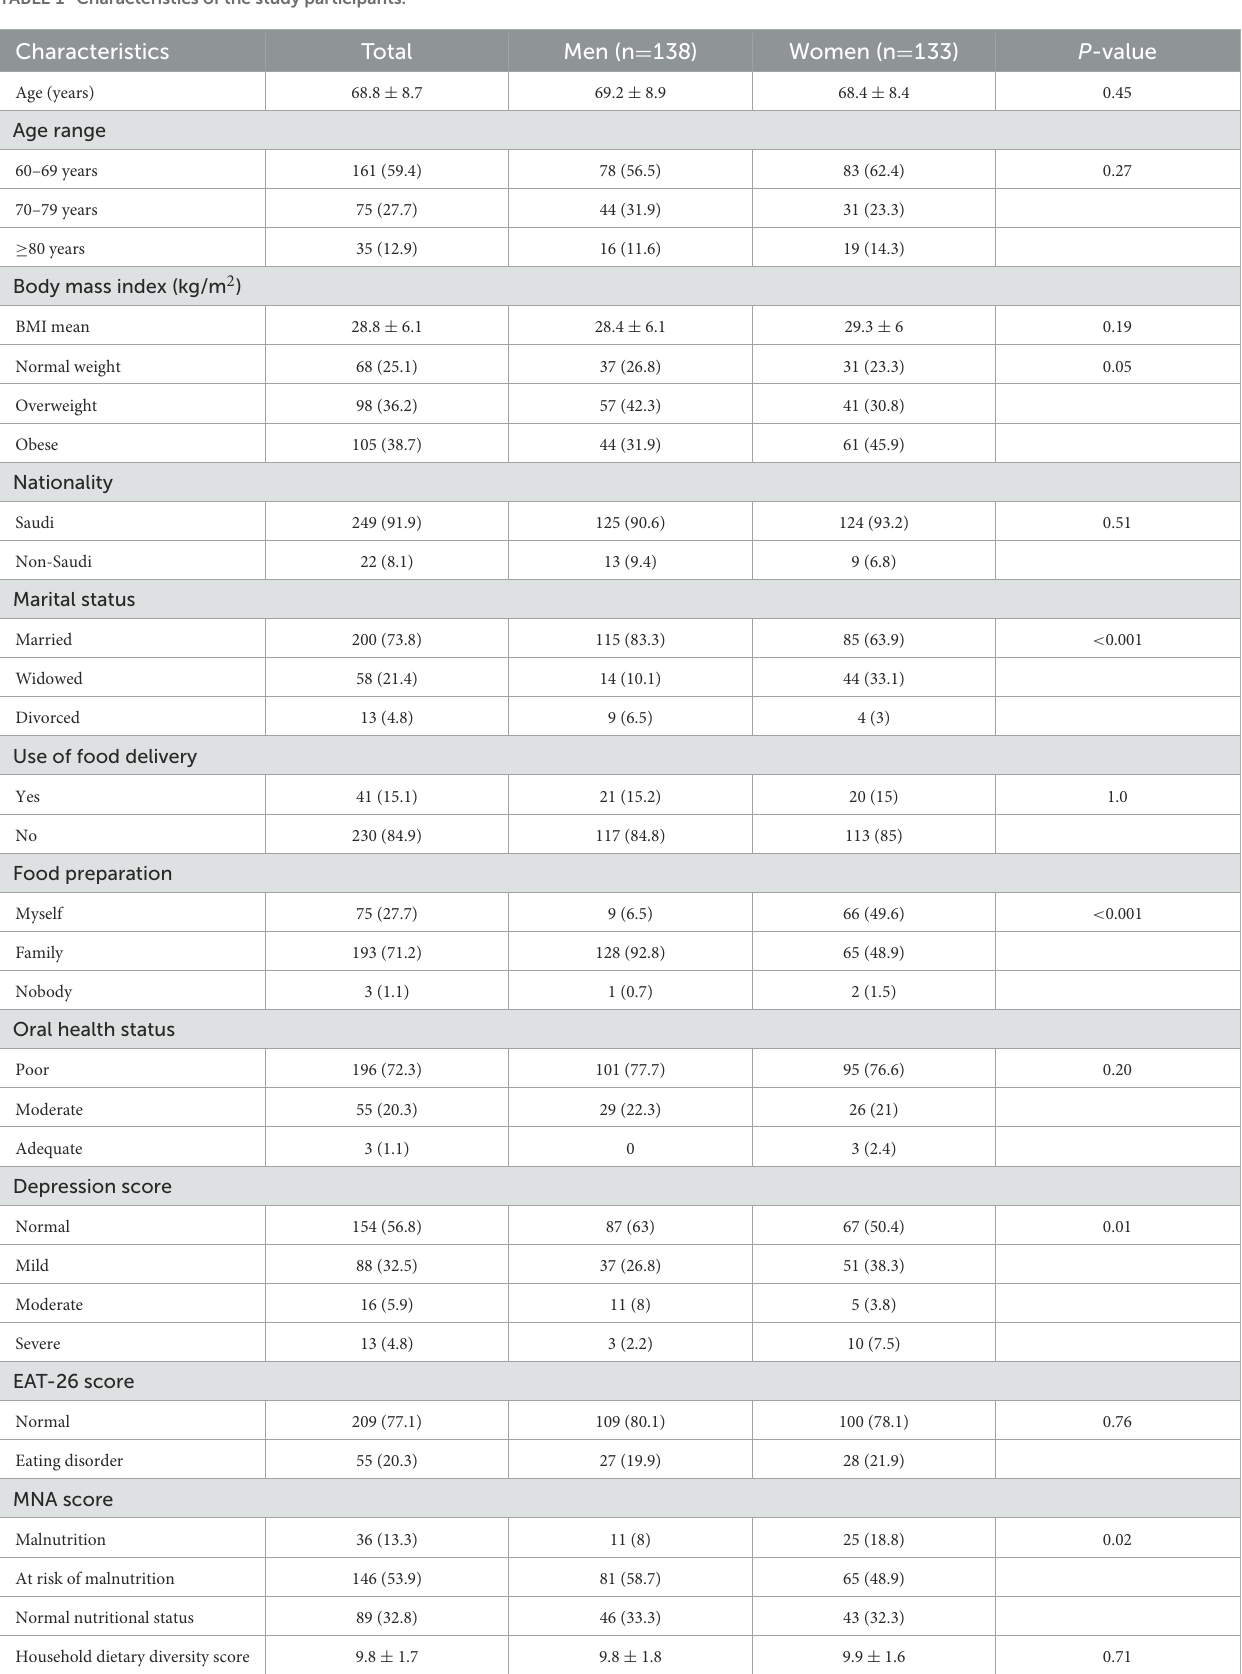
TABLE 1 Characteristics of the study